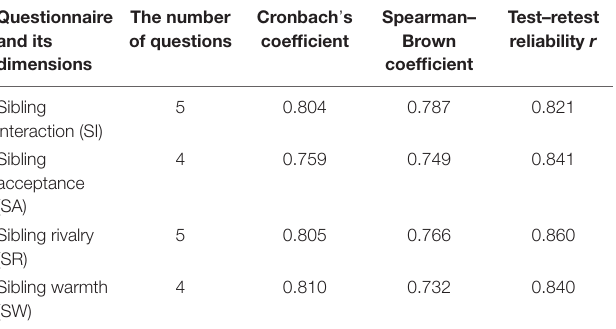
TABLE 4 | The reliability analysis of the